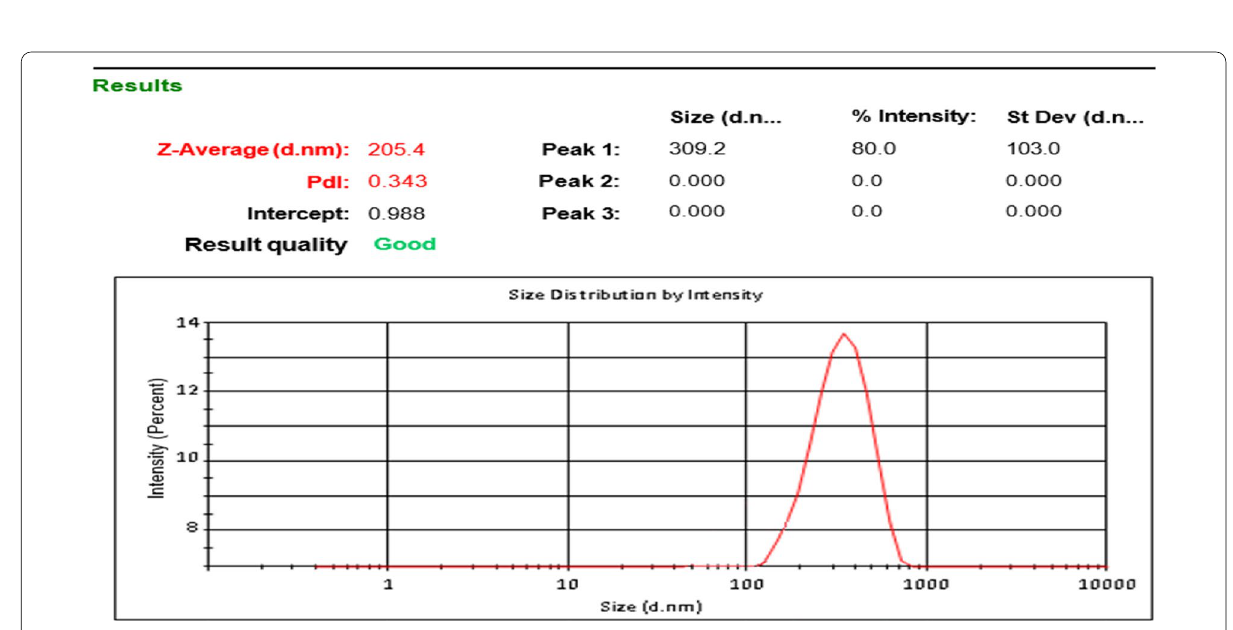
Fig. 9 Vesicle size distribution graph of optimized